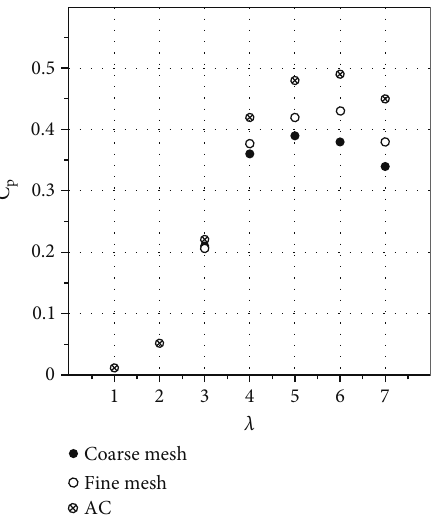
Figure 2: Power coe ffi cients (AC vs RANS-AC) as a function of the tip-speed ratio λ . B is the